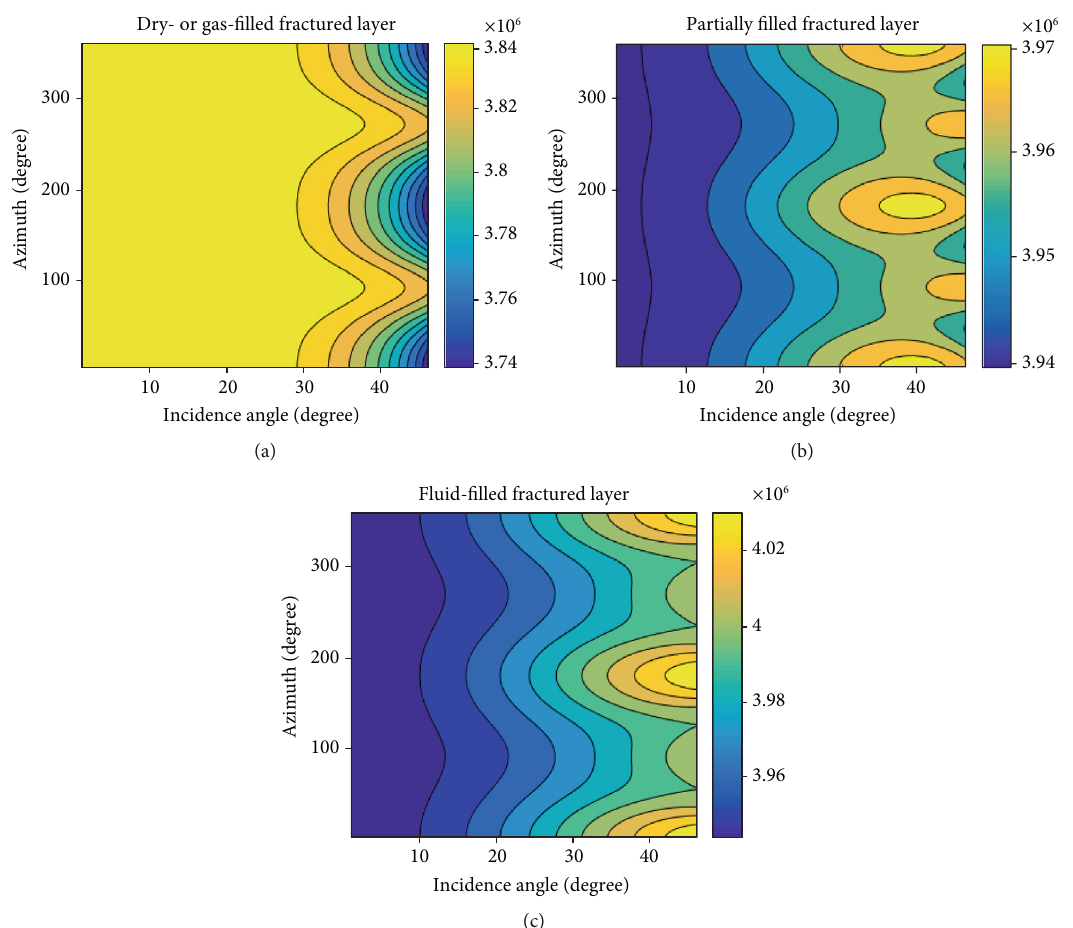
Figure 5: The sensitivity of PP-wave azimuthally anisotropic EI to the fl uid content of titled fractured reservoirs with fi xed dip angle, where (a) is dry or gas-saturated, (b) is partially saturated, and (c) is fully